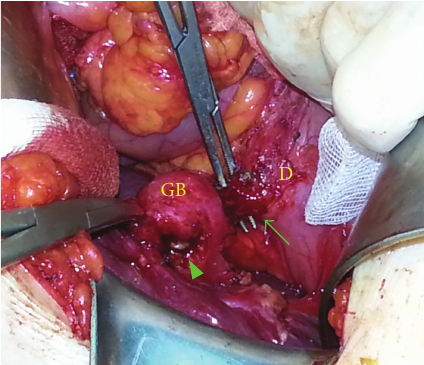
Figure 2: Incomplete cholecystoduodenal fistula. The arrow indi- cates the cholecystoduodenal fistula. The arrowhead indicates the cholecystogastric fistula opening on the gallbladder, which was previously